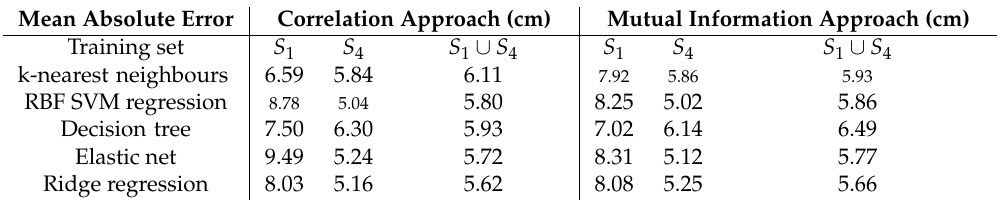
Table 7. Accuracy comparison of different training sets for the different machine learning algorithms validated on S 3 .